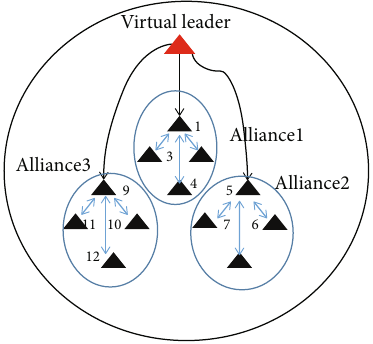
Figure 2: Hybrid hierarchical distributed formation structure.